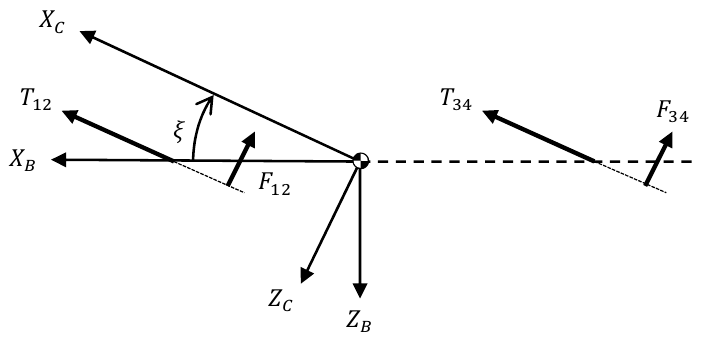
Figure 9. Definition of actuator coordinate system.